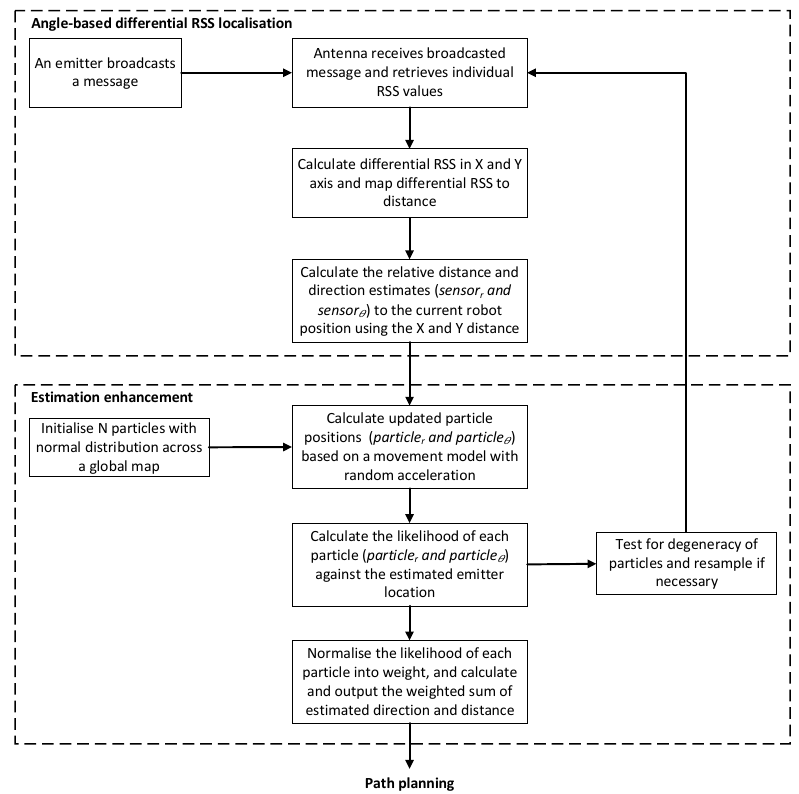
Figure 3. ( a ) Top view illustration of the physical arrangement of two pairs of antennae with their reflectors aligned along x and y axes, and ( b ) calculation of the estimated relative direction θ and distance r based on differential RSS.